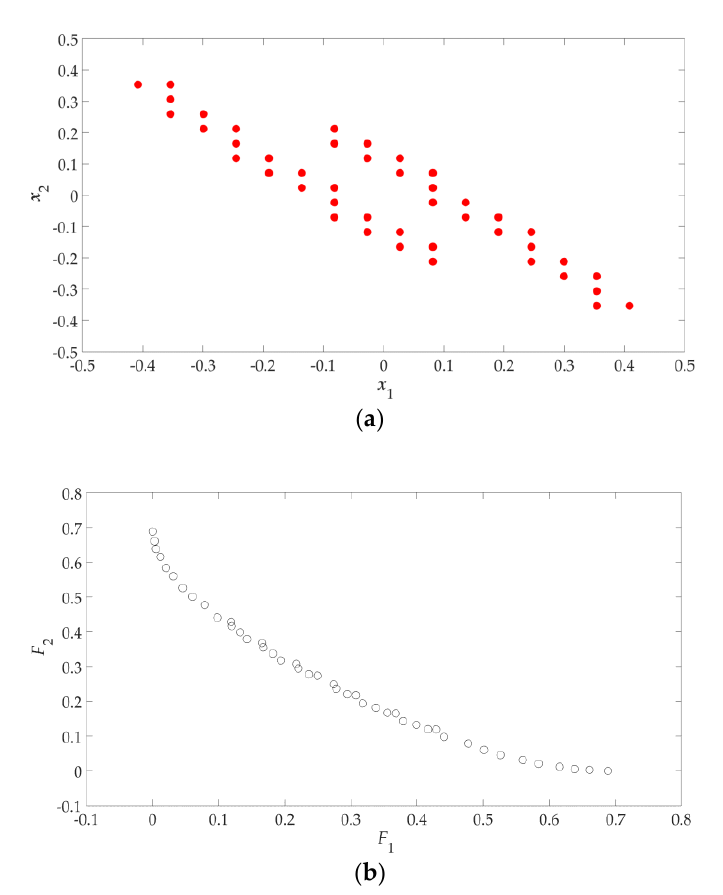
Figure 4. Results of two design objectives: ( a ) approximate Pareto set (design space); ( b ) approximate Pareto front (objective space).